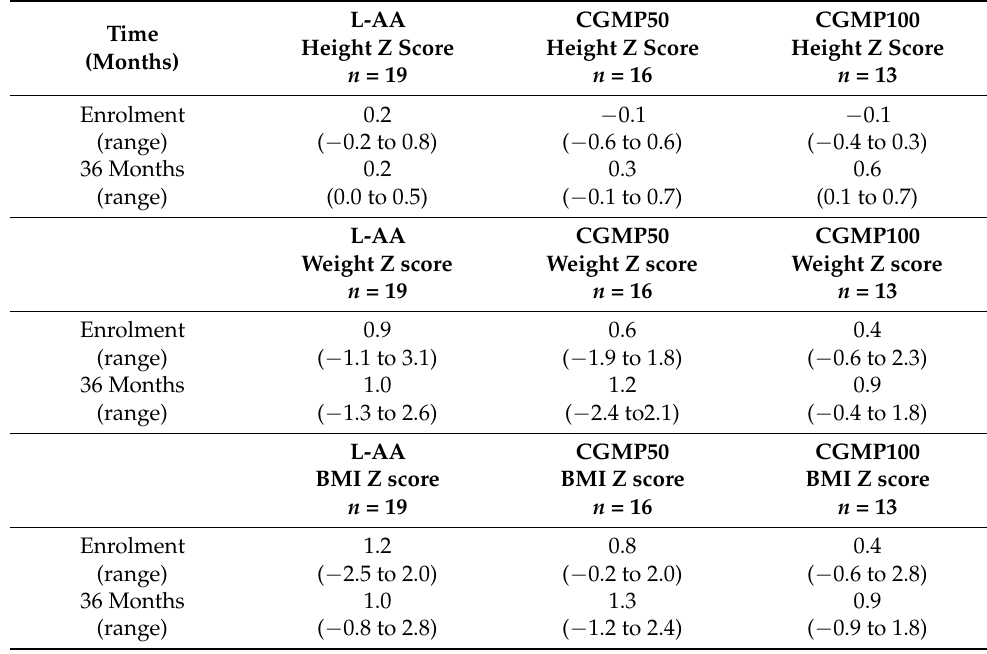
Table 6. Median z scores (range) for height, weight, and BMI in the L-AA, CGMP100, and CGMP50 groups, measured annually from enrolment to 36 months in PKU children taking either L-AA, CGMP50, or